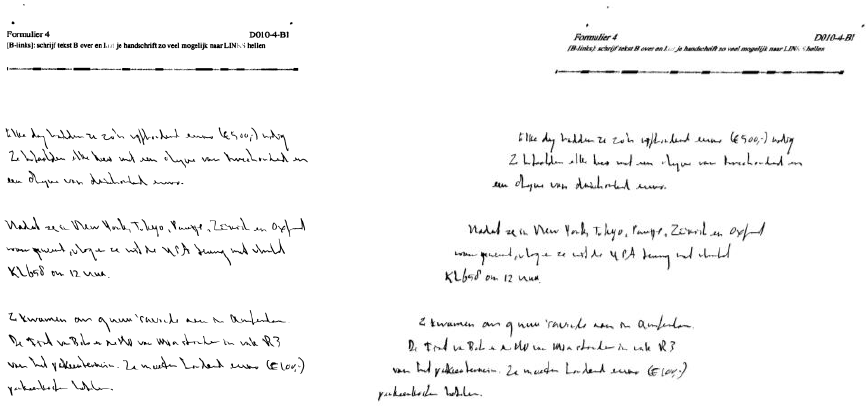
Figure 6. Application of the technique on a sample from the TrigraphSlant database ( left ); corrected by +28 degrees ( right ).